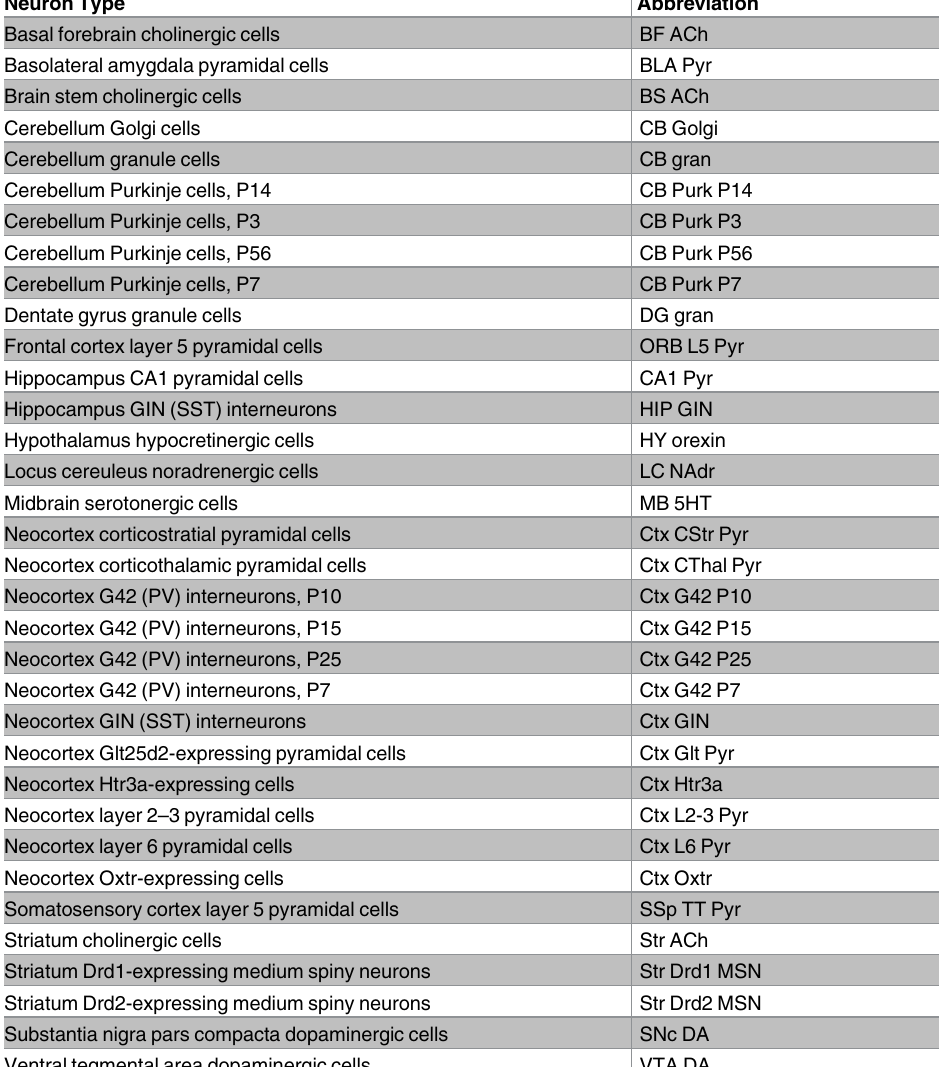
Table 1. Descriptions for neuron types composing the NeuroExpresso/NeuroElectro discovery data- set. Referencesfor individualtranscriptomic and electrophysiologicalsamples are available in S 2 Table . Neuron